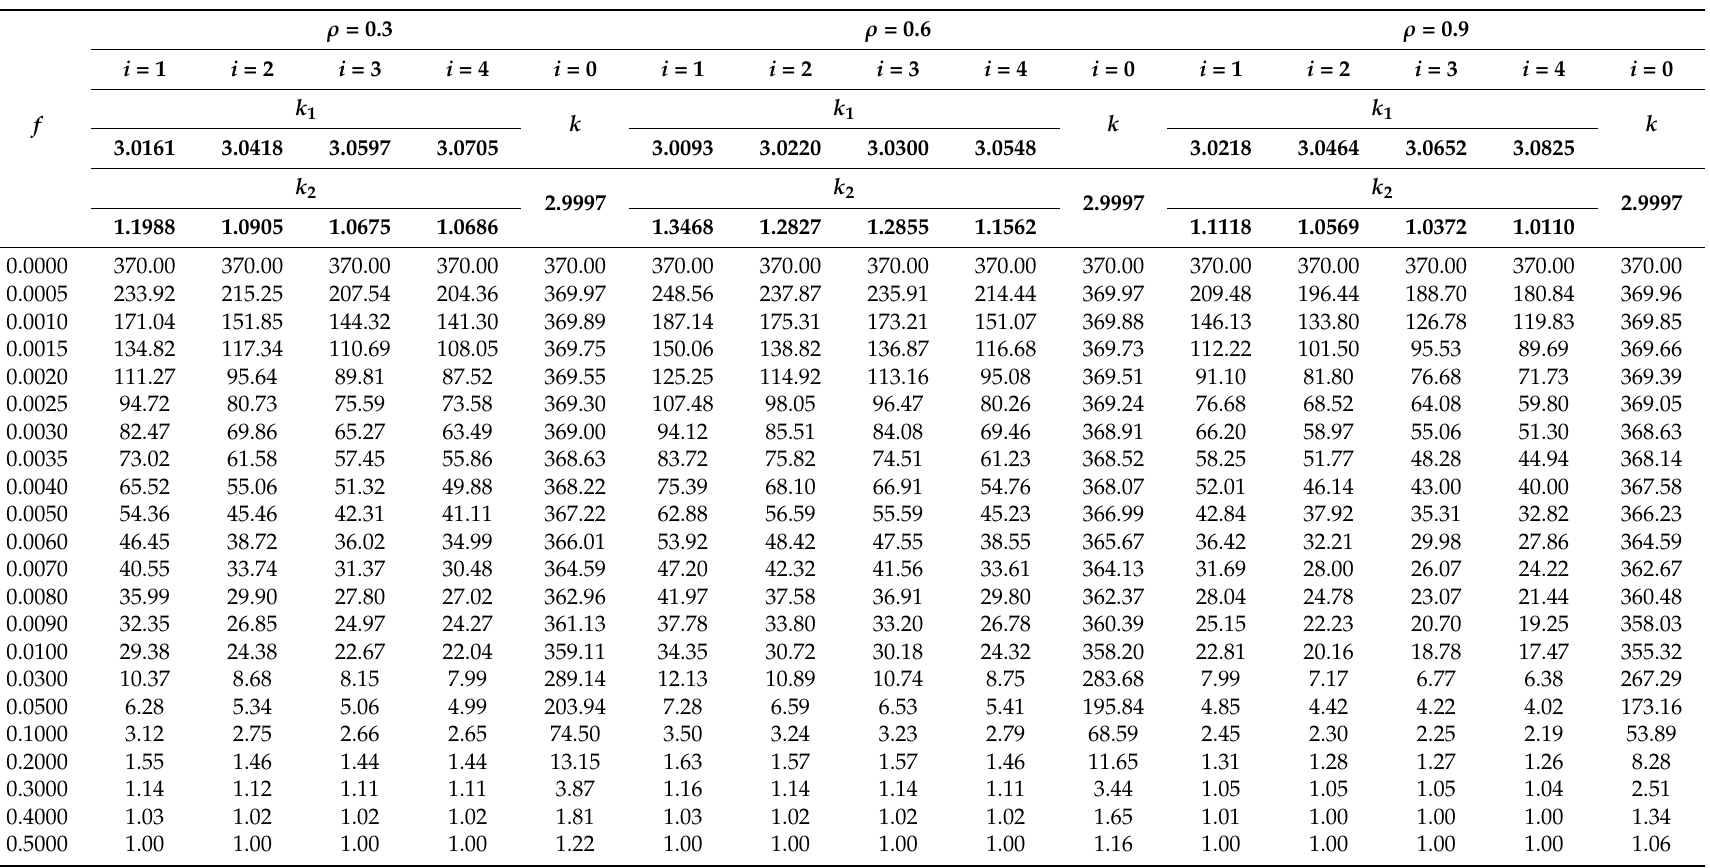
Table 6. The ARL analysis for 370 with n =